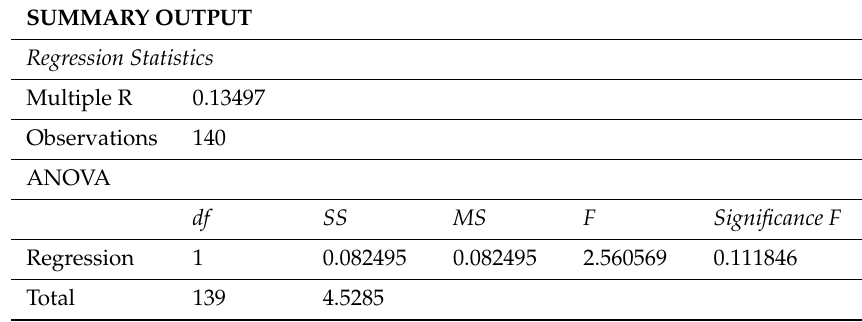
Table 6. Correlation—% share of private sector representation and utilization of the Community planning of social services